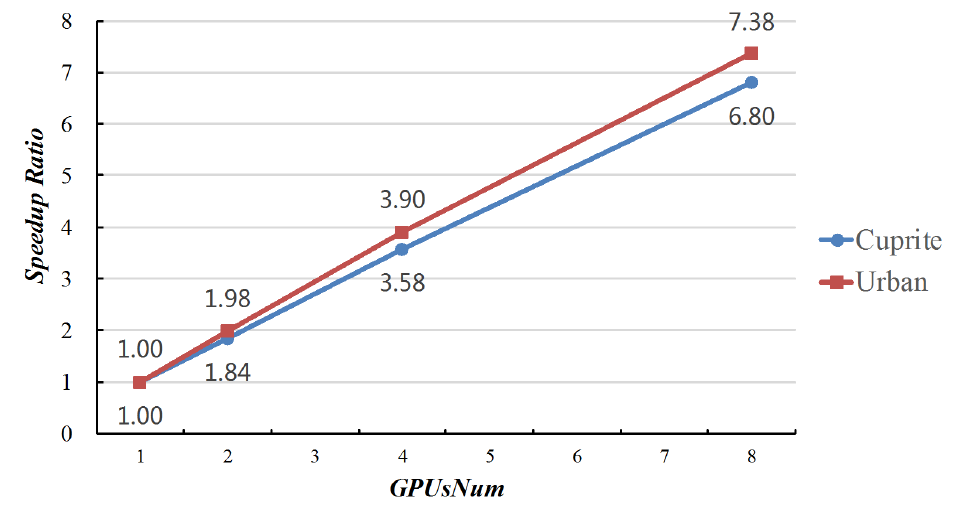
Figure 5. Speedup ratios of MG-ACOEE with different GPUsNum and G-ACOEE.